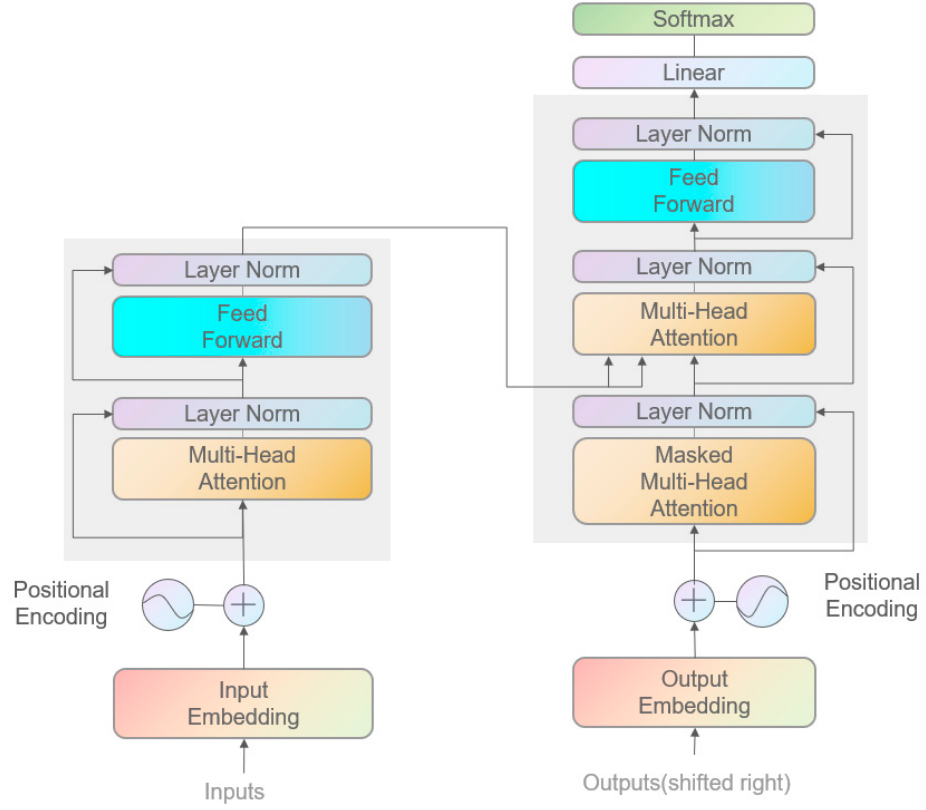
Figure 2. Structure of Transformer.